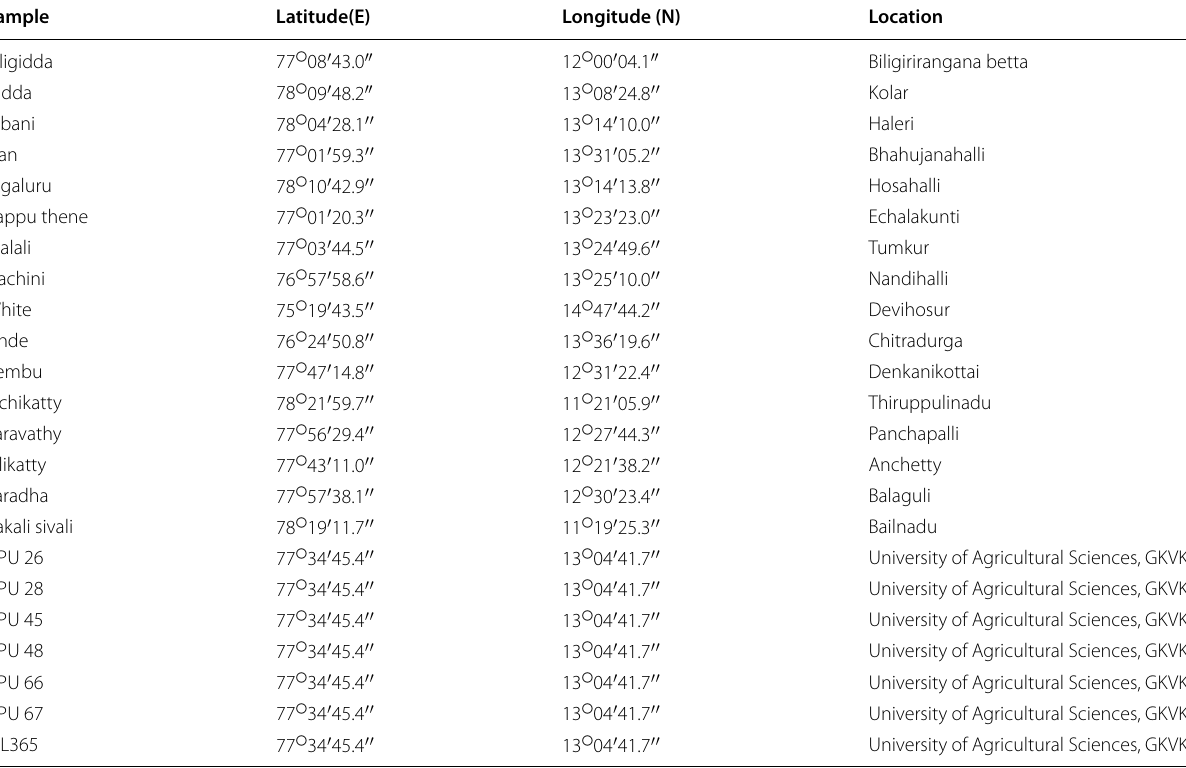
Table 1 Location of finger millet genotypes